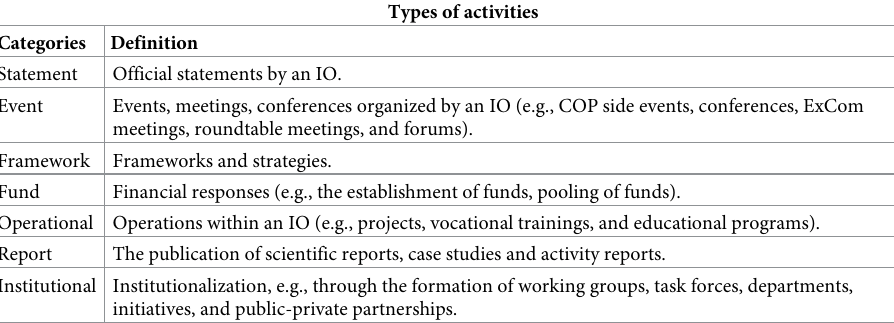
Table 2. Types of activities included in the